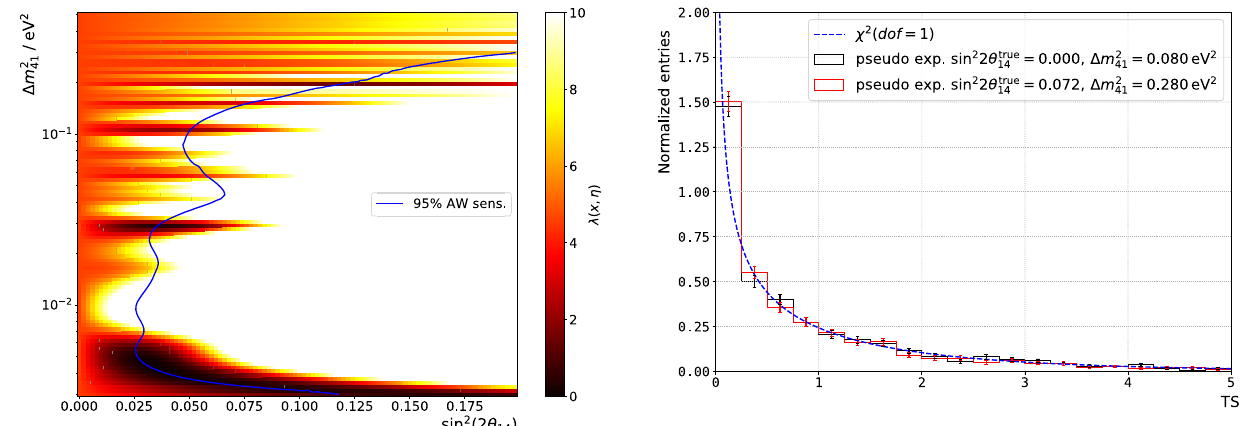
Fig. 7 Test statistic for fixed values of Δ m 2 . Shown are the results 41 from 1999 pseudo experiments when fitting sin 2 2 θ 14 for 100 discrete values of Δ m 2 for the injected null hypothesis. For comparison, the 41 expectation from a χ 2 distribution of one degree of freedom is 41